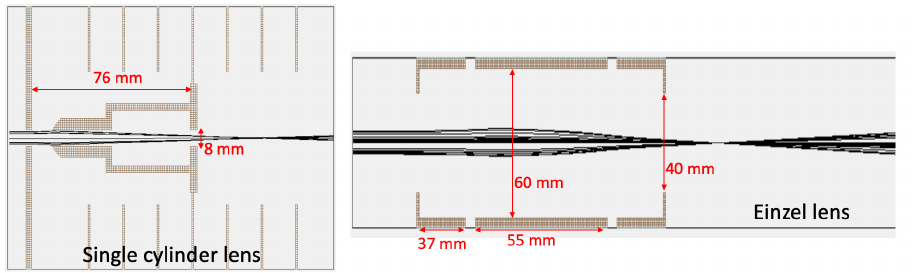
Figure 5. Schematic diagram of focal electrodes ( left : single cylinder system; right : einzel lens system) and simulations of the focusing effect in SIMION. The potentials of the electrodes were altered to show the focusing